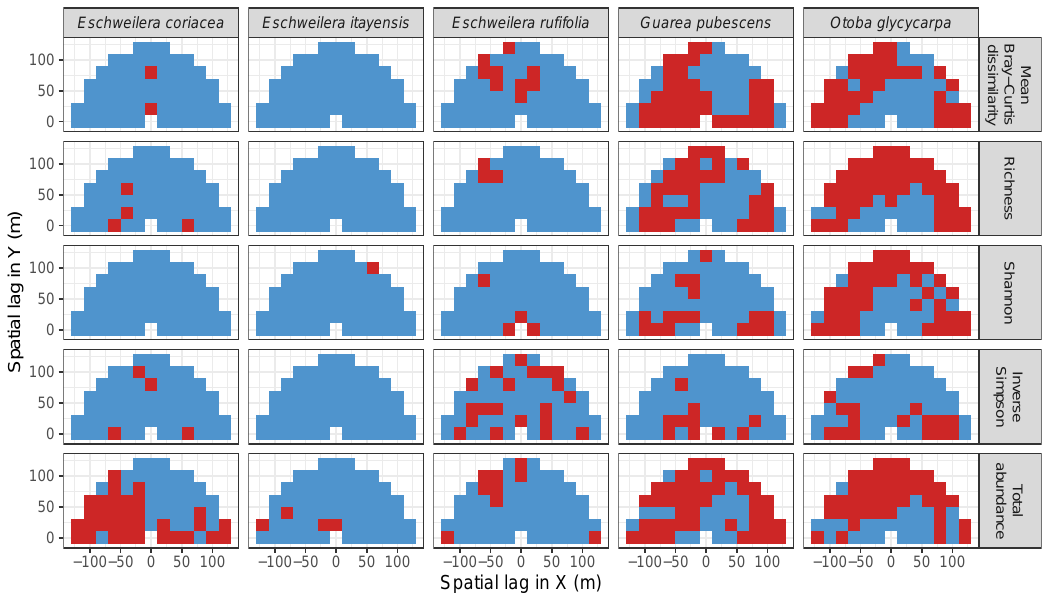
Figure 20. Statistical significance (red: P 0.05; blue: P > 0.05) of the codispersion coefficients ≤ calculated between measures of diversity and total basal area of the five focal tree species in 20 20-m × subplots in the 25-ha Amacayacu plot (Figure 17). Statistical significance was determined by comparing observed codispersion at each spatial lag with a distribution of 199 spatial randomizations of a toroidal-shift null model. See Figure A5 for significance testing using a CSR null model.